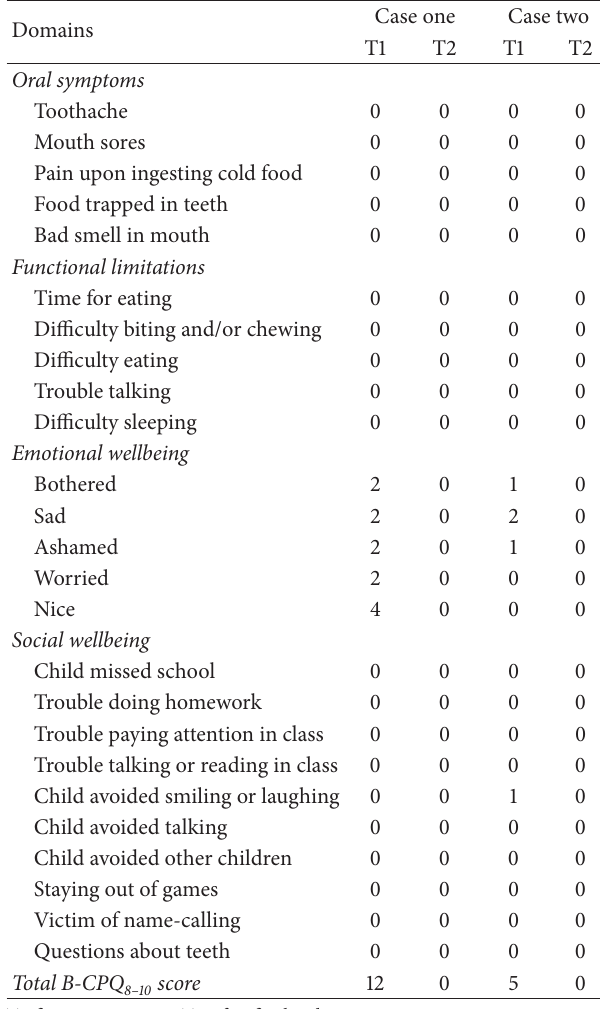
scores at two different points in